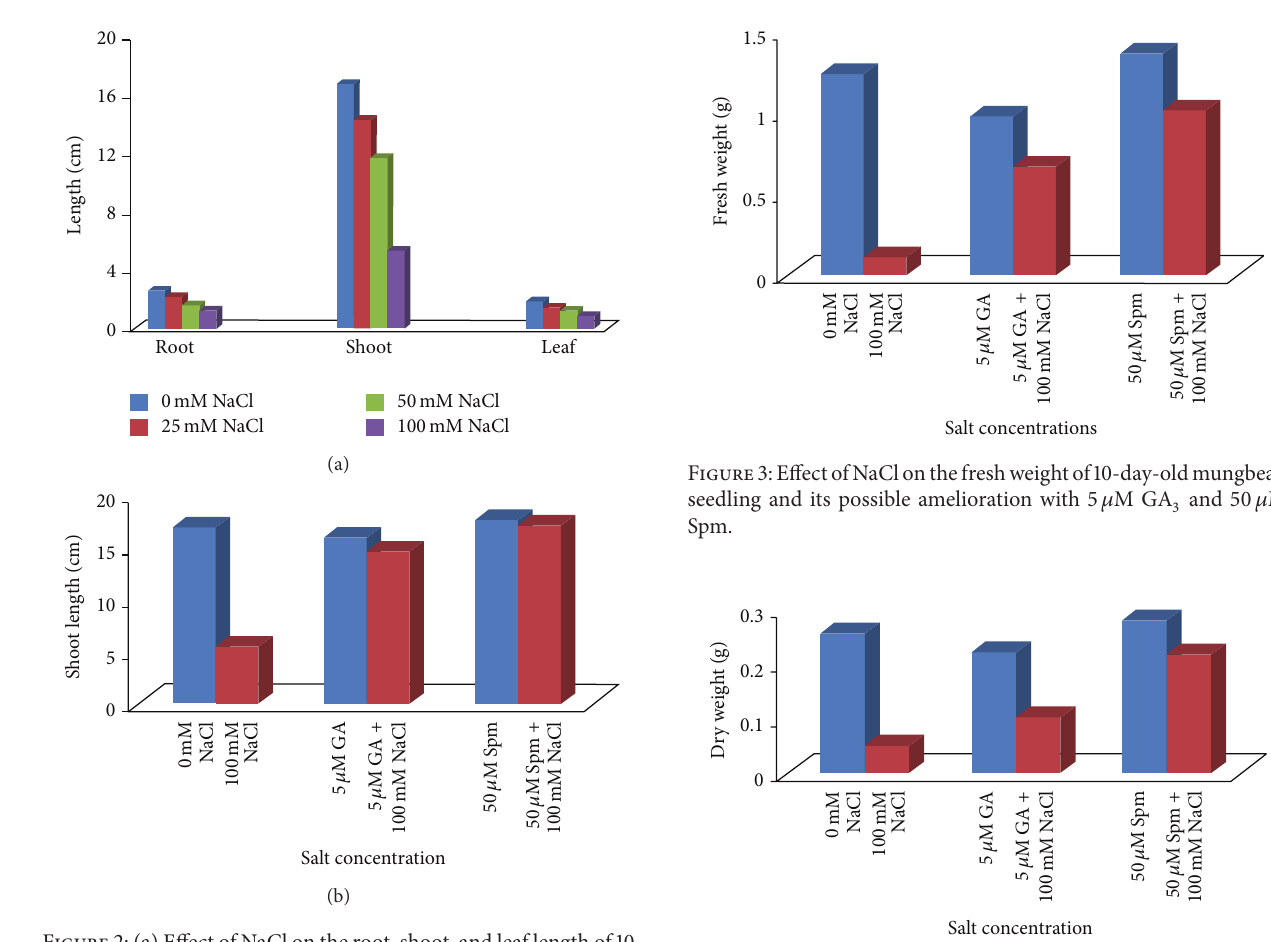
Figure 4: Effect of NaCl on the dry weight of 10-day-old mungbean seedling and its possible amelioration with 5 𝜇 M GA 3 and 50 𝜇 M